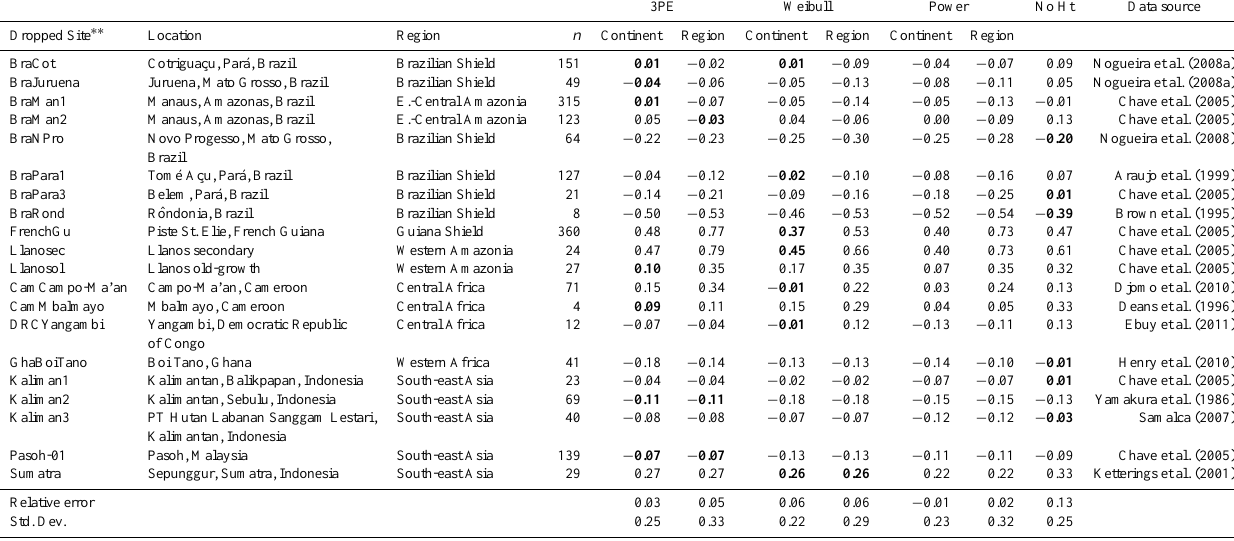
Table 2. Efficacy of biomass models including or excluding tree H to predict true (destructively) sampled biomass for trees ≥ 10 cm D for individual sites excluded from model formulation. Values represent bootstrapped mean relative error, or bias (( B predicted – B measured ) / B measured ), for a site, in dry biomass estimated from a biomass model excluding H (Eq. 1), and biomass including H (Eq. 2) using various H models (Eqs. 3–5) based on region- and continent-specific H models. Values in bold indicate the model with the lowest mean relative error (bias) for a site (this excludes the power model, which although it has the lowest overall bias and standard deviation, fails to reduce error in the small diameter classes). ∗